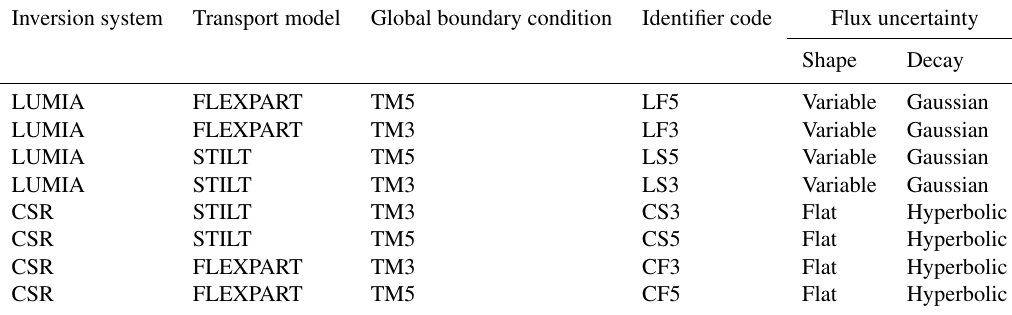
Table 2. List of the inversion